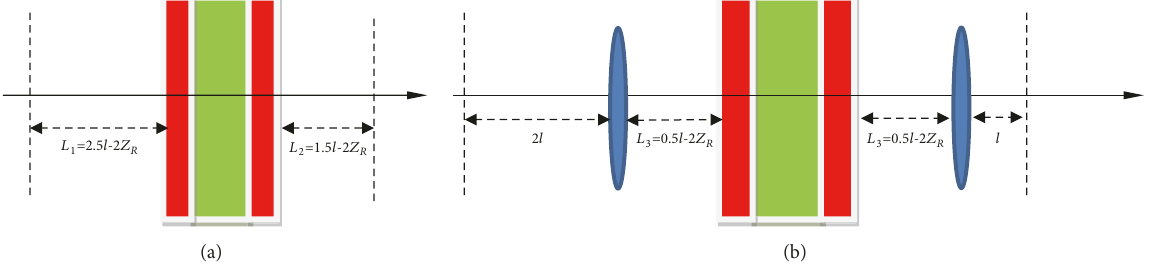
Figure 5: Equivalent lens sequence diagram of ring resonators for two kinds of curvature radius, 𝜔 0 =0.1 × 10 −3 m, 𝑛 𝑟 =1.55, 𝜔 𝑝𝑒 = 𝜔 𝑝𝑚 = 2𝜋 ] × √2.55 , 𝑍 𝐿 =2 𝑍 𝑅 = 𝑍 𝑙 =0.2m, and 𝜆 =632.8nm fixed: (a) 𝑟 󳨀→ ∞ ; (b) 𝑟 𝑅 =4.9646cm, 𝑅 , 𝑅 ,